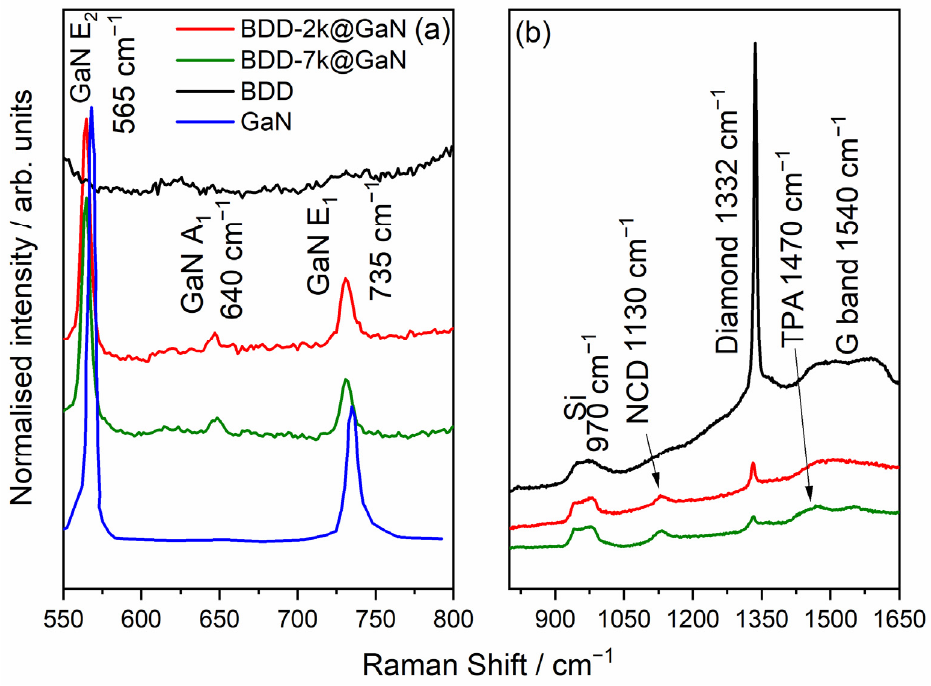
Figure 3. Raman spectra of boron-doped diamond films with different boron doping levels: red curve 2000 ppm, green curve 7000 ppm. ( a ) Raman spectra form 550 cm − 1 to 800 ( b ) Raman spectra form 875 cm − 1 to 1650. Table 2. The parameters of the Raman bands for BDD-2k@GaN and